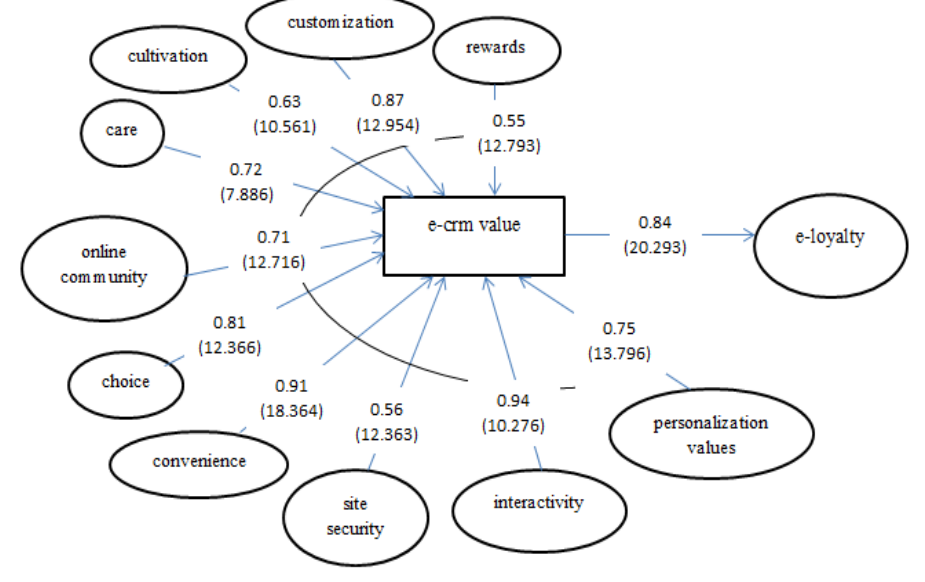
Figure 2. Research model results. Table 4. Structural Equation Modeling Model (SEM-Model) results.